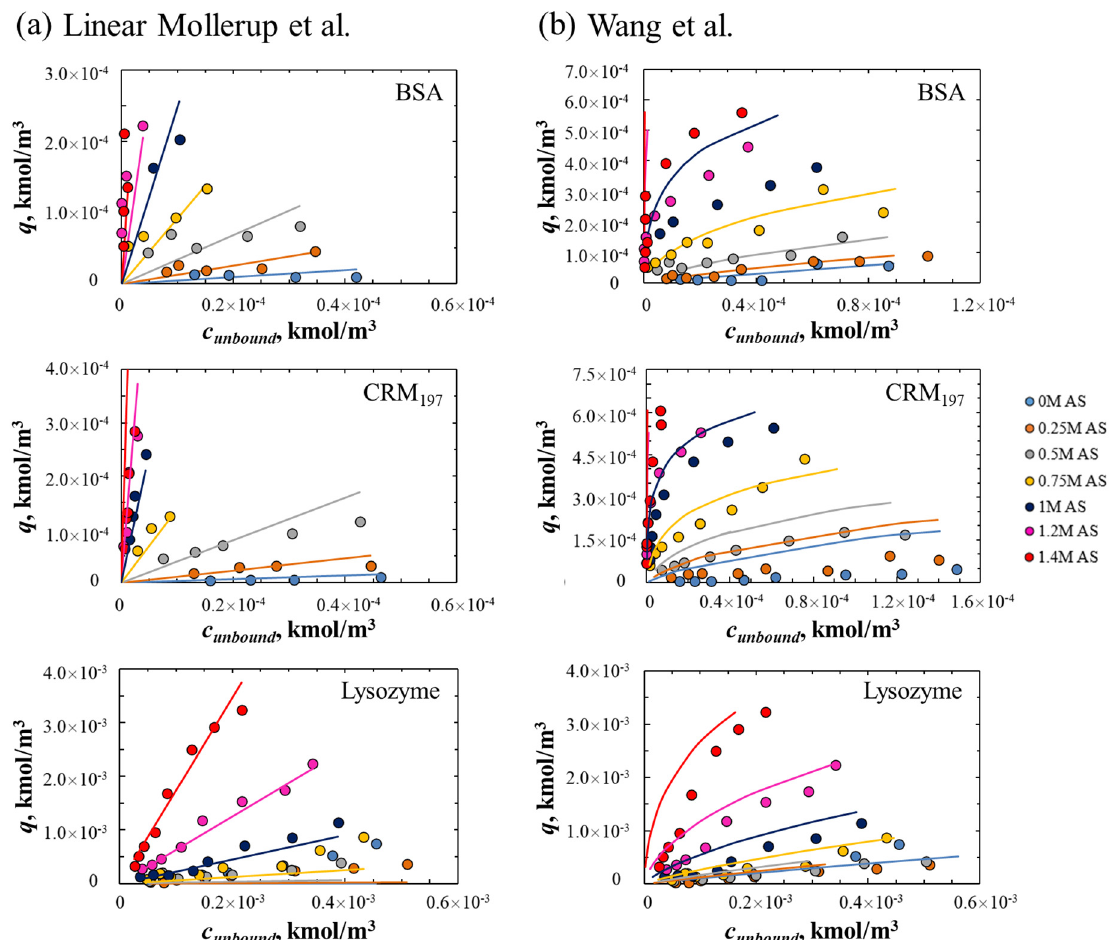
Figure 5. ( a ) Experimental adsorption isotherms of BSA, CRM 197 and Lysozyme fitted with the linear model of Mollerup et al. [71]. ( b ) Experimental adsorption isotherms of BSA, CRM 197 and Lysozyme fitted with the Wang et al. [55] model at the equilibrium.